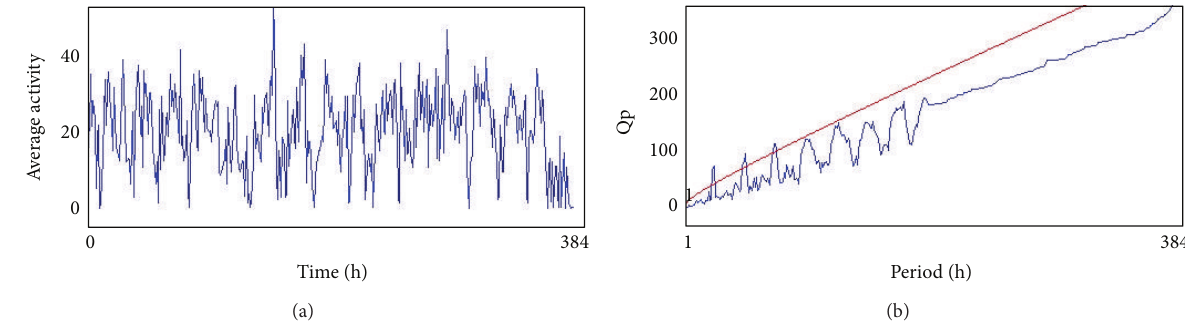
Figure 9: (a) and (b) show the average activity pattern and chi-square periodogram, respectively, for the PD flies exposed to 0.50 𝜇 L/mL of Centella asiatica leaf extract in diet ( 𝑁 = 20 ).